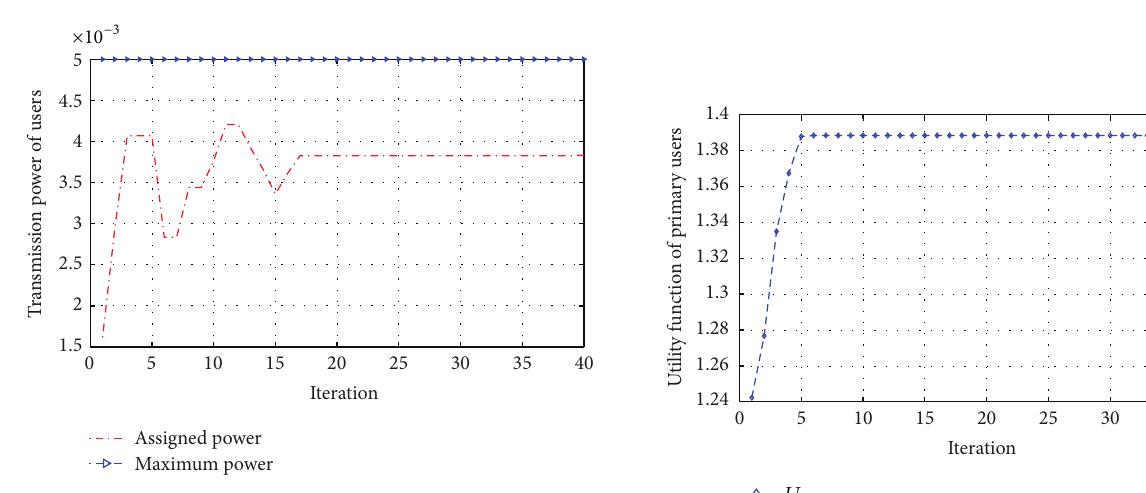
Figure 4: Convergence of transmission power for secondary users.